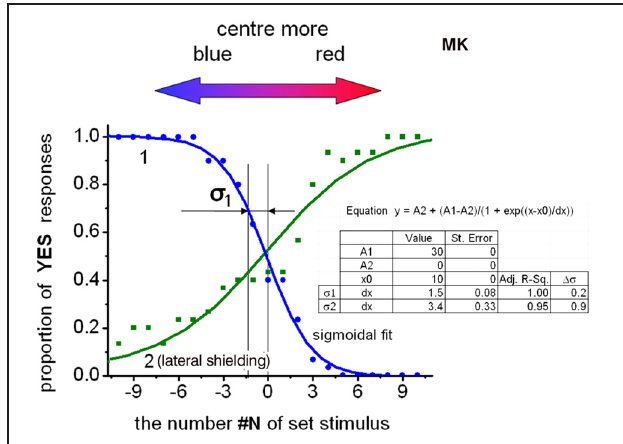
FIGURE 3 | Psychometric curves to determine the threshold of color difference to detect the induced color stereo effect. The curves are – corresponding to viewing with uncovered pupils (curve 1) and curve corresponding to viewing with lateral shielding (curve 2). Parameters of sigmoidal fit of experimental points and of statistical data analysis are depicted in